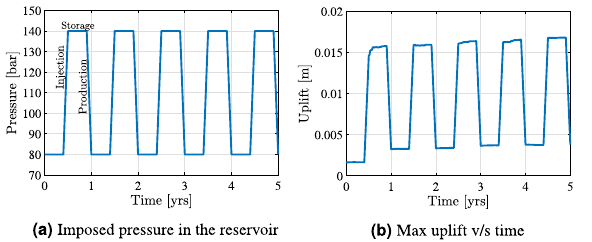
Figure 11. Field scale test case: the imposed pressure load is shown in Fig. 11 (a) . Figure 11 (b) shows the variation of the maximum uplift with time caused due to the imposed